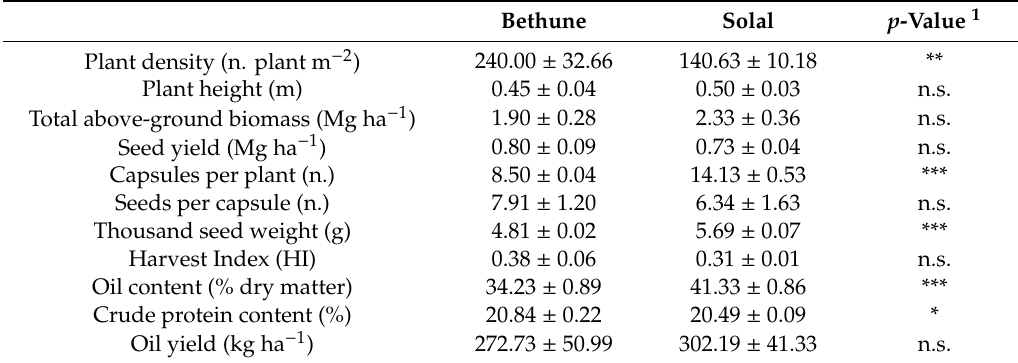
Table 2. Yield and yield components (results are the means ± standard deviation of four replicates) in two linseed varieties (Bethune and Solal) at harvest (6 July